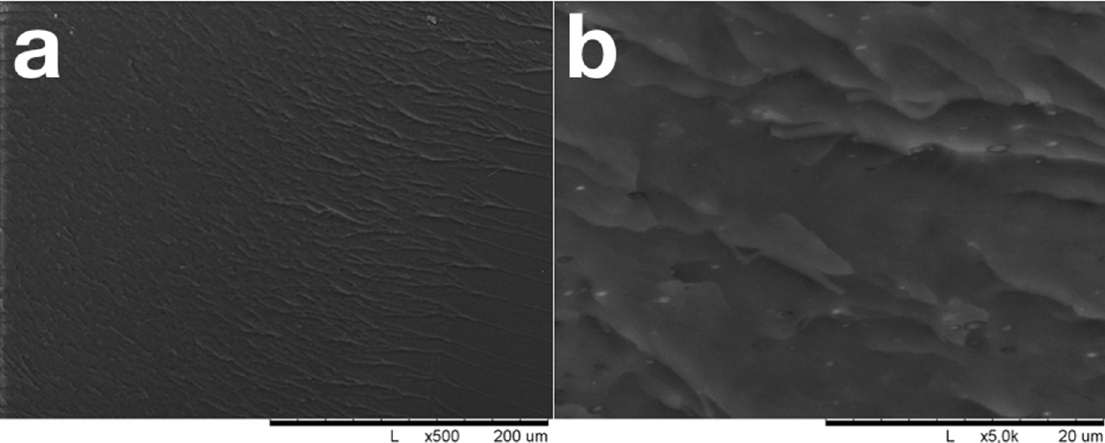
Figure 3. SEM images of carbonized pure NBR fracture surface.